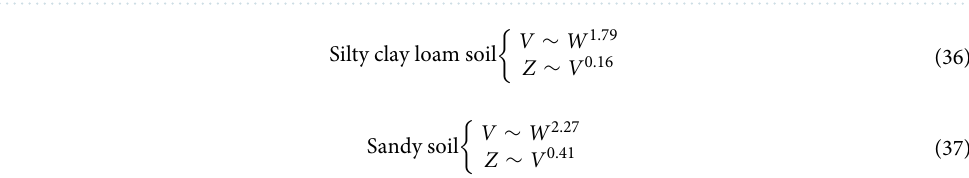
Figure 4. Comparison of observed W o and Z o vs simulated W s and Z s from estimated V for silty clay loam ( a , b ) and sandy soil ( c , d